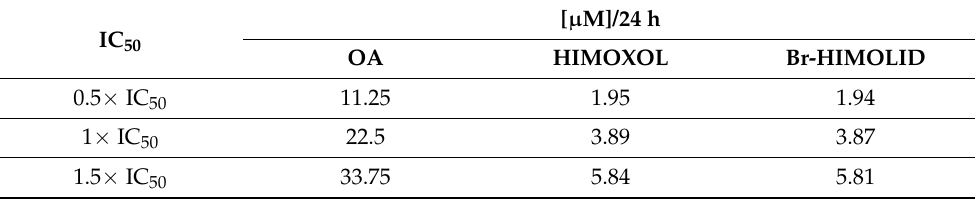
Table 2. The concentration range of compounds applied in all